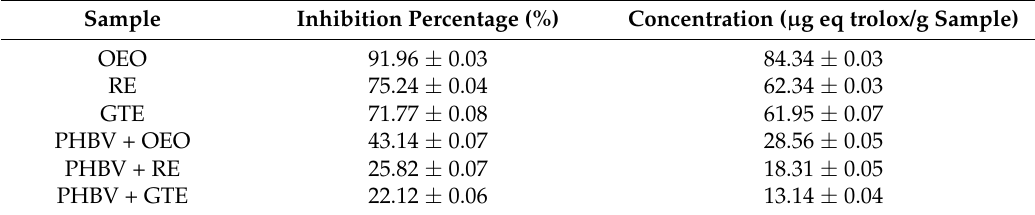
Table 7. Inhibition percentage (%) of 2,2-diphenyl-1-picrylhydrazyl radical (DPPH) and concentration (eq. trolox/g sample) of DPPH for oregano essential oil (OEO), rosemary extract (RE), and green tea tree extract (GTE) and the electrospun fibers of poly(3-hydroxybutyrate- co -3-hydroxyvalerate) (PHBV) containing OEO, RE, and